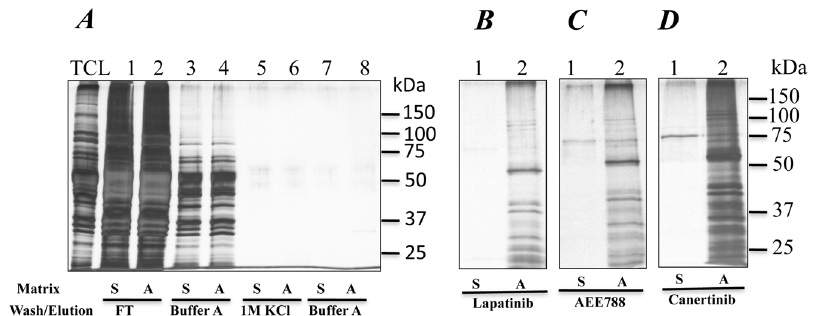
Figure 3. Drug elution of T.brucei protein kinases using an ATP-affinity resin. Proteins in total cell lysate from T. brucei were bound on ATP resin. Sepharose 4B resin was used as control. Unbound proteins (Flow through) were recovered and resin was washed sequentially with buffer A and buffer A containing 1 M KCl (Panel A). Bound proteins were eluted with lapatinib (100 m M), or AEE788 (100 m M) or canertinib (100 m M) (Panel B, C and D, respectively). Proteins were visualized by silver staining. Matrix label, A is ATP-sepharose, and S is Sepharose 4B.